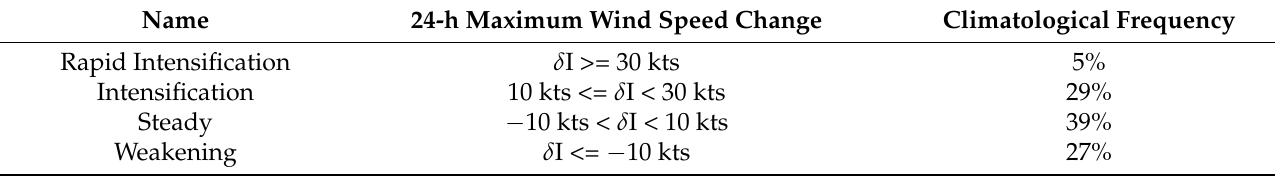
Table 2. Intensity change categories used in this